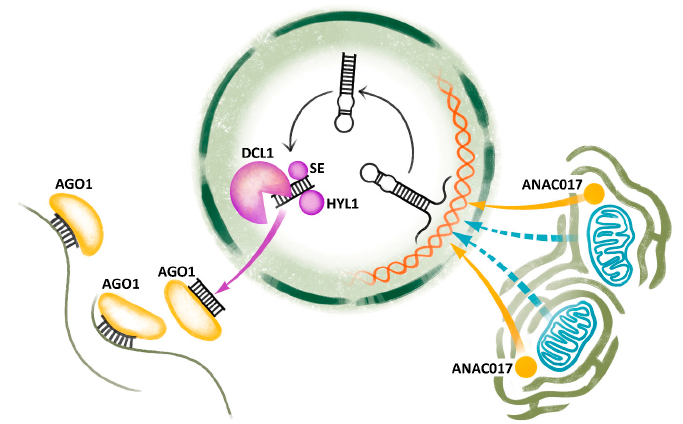
Figure 1. Induction and biogenesis of miRNA during CMS. Mitochondrial biogenesis is altered by the action of cytoplasmic male sterility (CMS)-associated genes sending retrograde signals to the nucleus by means of the NAC transcription factor ANAC017 localized close to endoplasmatic reticulum and/or by other unknown factors. They trigger miRNA gene expression and the production of pri-miRNA, which is subsequently trimmed by the complex containing DICER LIKE1 (DCL1), HYPONASTIC LEAVES1 (HYL), SERRATE (SE) and other proteins in the nucleus. Afterwards, miRNA duplexes are transported to the cytoplasm, where they join ARGONAUTE1 (AGO1), find target mRNAs and initiate its cleavage or translation inhibition by RNA-induced silencing complex (RISC). The figure is based on well-supported model except for blue dashed arrows representing an unknown signal.